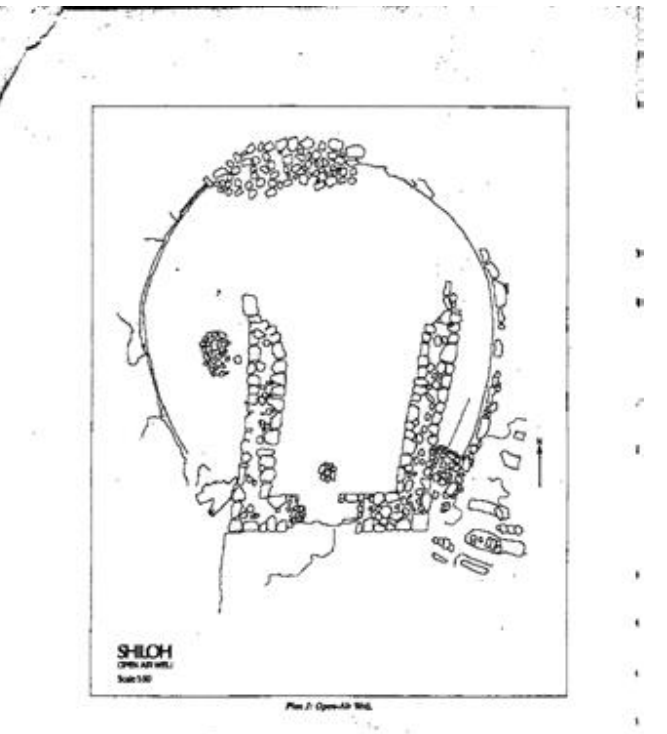
Figure 6. The plan of the open-air Weli, from Andersen 1985, plan J.